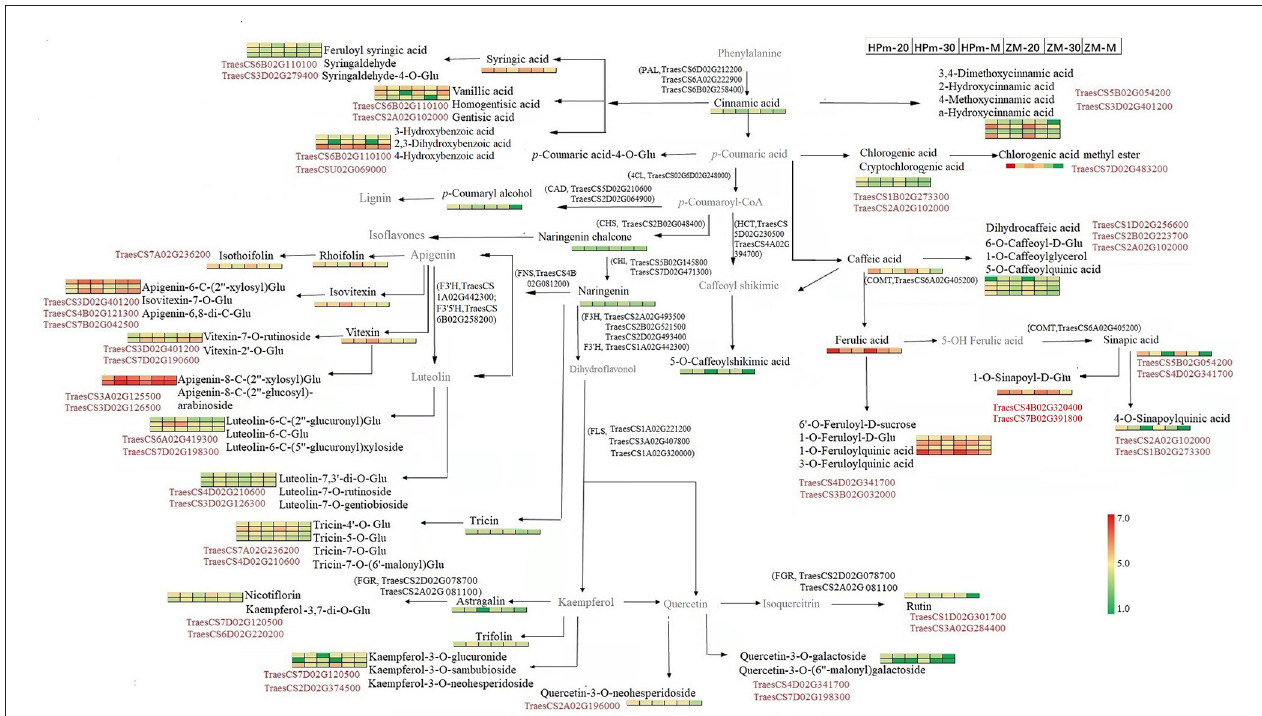
FIGURE 8 | Schematic map of phenolic biosynthesis pathway involved in wheat grains during the grain filling stage. The 1 × 6 heat map represents normalized relative metabolite abundance of grains at a different stage. Red color represents higher abundance, and green color represents lower abundance. HPm-20, HPm-30, and HPm-M are samples from cultivar HP512 at 20 days after anthesis (DAA), 30 DAA, and maturity, respectively. ZM-20, ZM-30, and ZM-M are samples from cultivar ZM22 at 20 DAA, 30 DAA, and maturity, respectively. Metabolites in black color represent significantly expressed metabolites. The gene number in black color represents the biosynthesis process, which is catalyzed by the enzyme encoded by this gene. The gene number in red color represents a significant correlation between this gene and its nearby metabolite. CAD, Cinnamyl alcohol dehydrogenase; CHS, Chalcone synthase; CHI, Chalcone isomerase; 4CL, 4-Coumarate-CoA ligase; FGR, Flavonol − 3-O gucoside L-rhamnosyltransferase; FNS, Flavone synthase; COMT, Caffeate-O-methyltransferase; F3H, Flavanone 3-hydroxylase; F3 ′ H, Flavonoid 3-monooxygenase; F3 ′ 5 ′ H, Flavonoid 3 ′ ,5 ′ -hydroxylase; FLS, Flavonol synthase; PAL, Phenylalanine